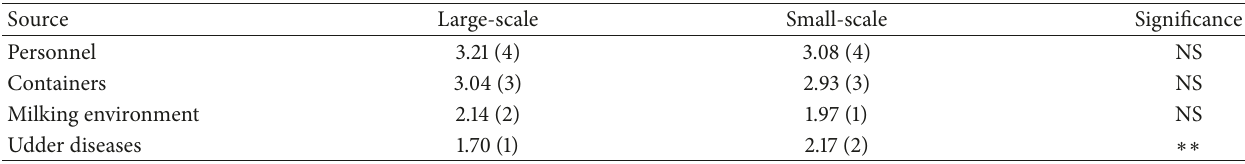
Table 3: Mean rank score (ranks) for causes of milk spoilage during milking in commercial and small-scale dairy farms. Source